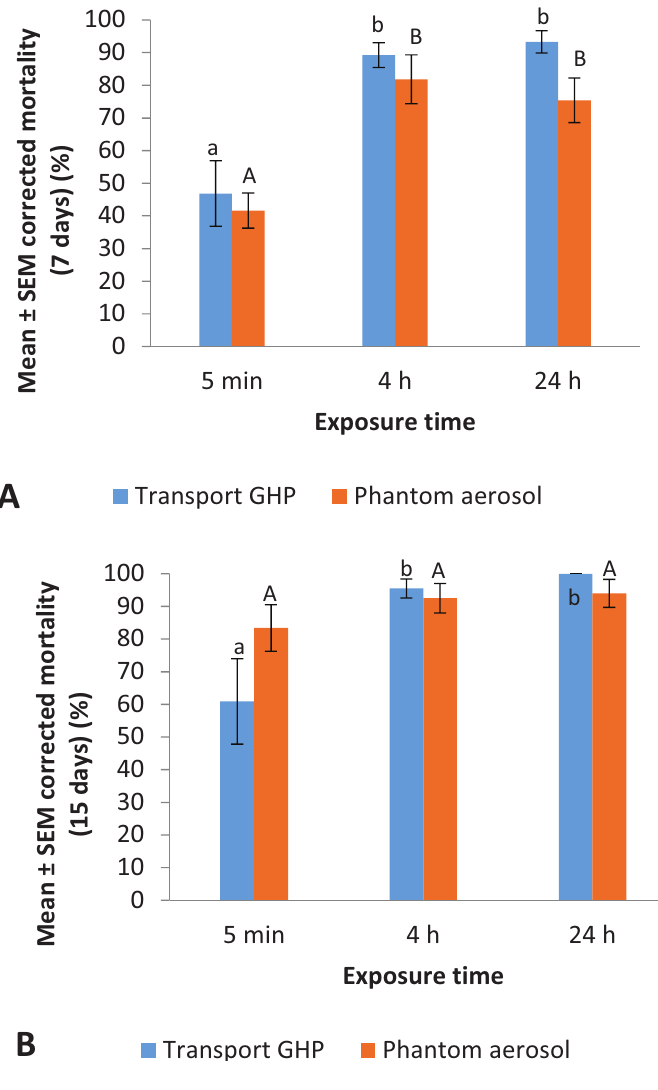
Figure 3. Effect of exposure time on residual efficacy of a liquid spray and an aerosol on vinyl substrate against Cimex lectularius . ( A ) 7 days; ( B ) 15 days. For each insecticide, bars with same letter are not statistically different (ANOVA, p > 0.05).